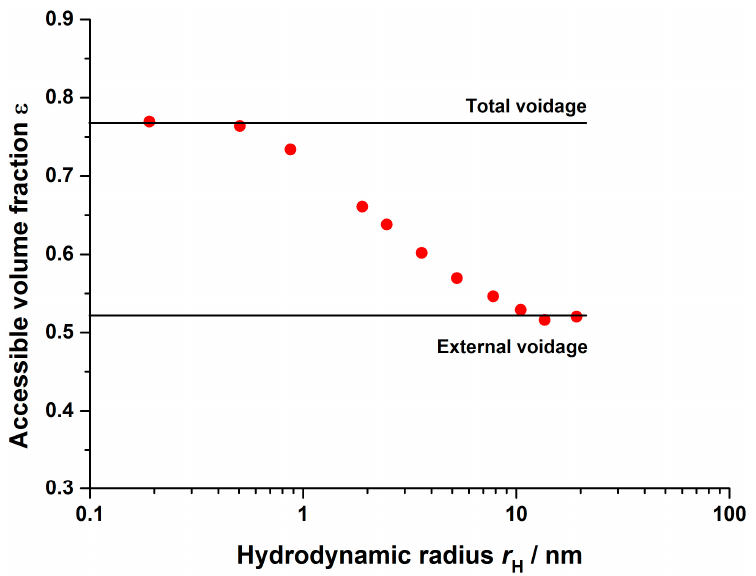
Figure 3. Accessible volume fractions depending on the pullulan tracer hydrodynamic radius. Buffer: 10 mM KPi, pH = 6, 20 mM NaCl.